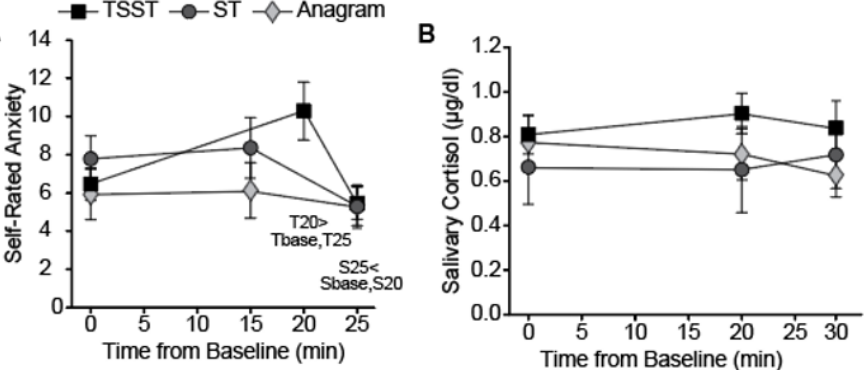
Figure 4. Self-rated anxiety and salivary cortisol in response to laboratory stressors. ( A ) Self-rated anxiety was elevated after the completion of the TSST and suppressed after the ST. ( B ) There was no change in salivary cortisol in response to the conditions. All significant effects are p < 0.05.